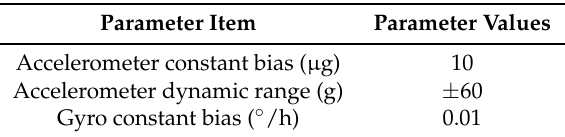
Table 4. Parameters of the gyroscope and